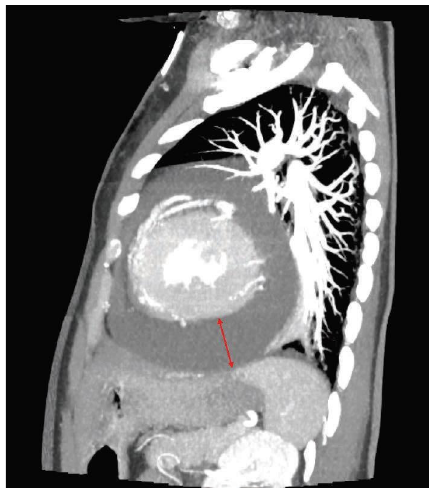
Figure 5: Chest CT with angiography: sagittal view shows large pericardial efusion (red line) without pericardial or pleural thickening or pericardial or pleural masses.